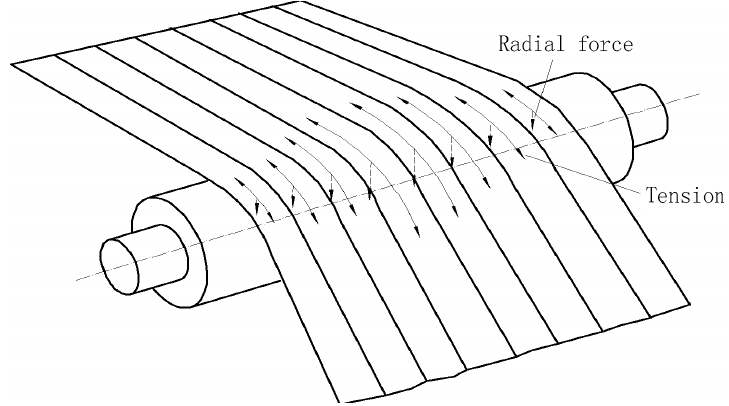
Figure 6. Detection principle of the entire roller-embedded shapemeter.